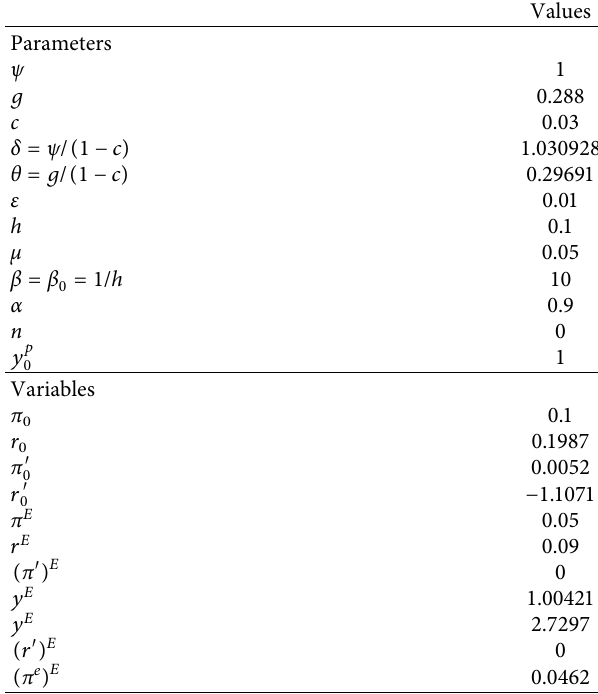
Table 2: Parameter values and initial and equilibrium values of the model variables (